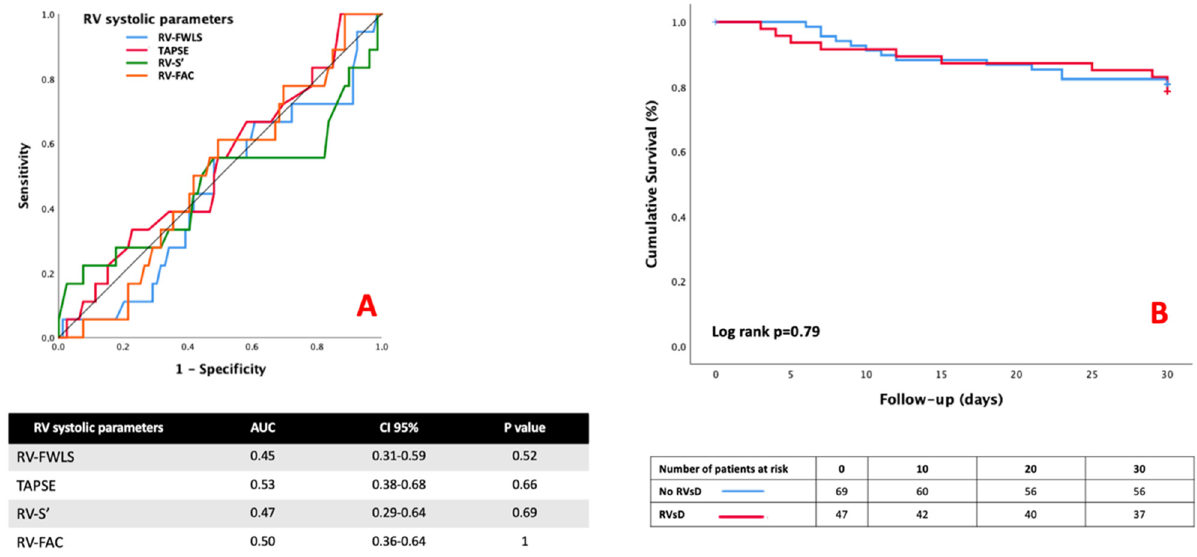
Figure 3. ( A ) ROC curve analysis of RV systolic parameters for predicting 30-day mortality. ( B ) Kaplan–Meier curve analysis between the RVsD group and no-RVsD group. Table 3. Univariate and multivariate Cox analysis of variables associated with 30-day